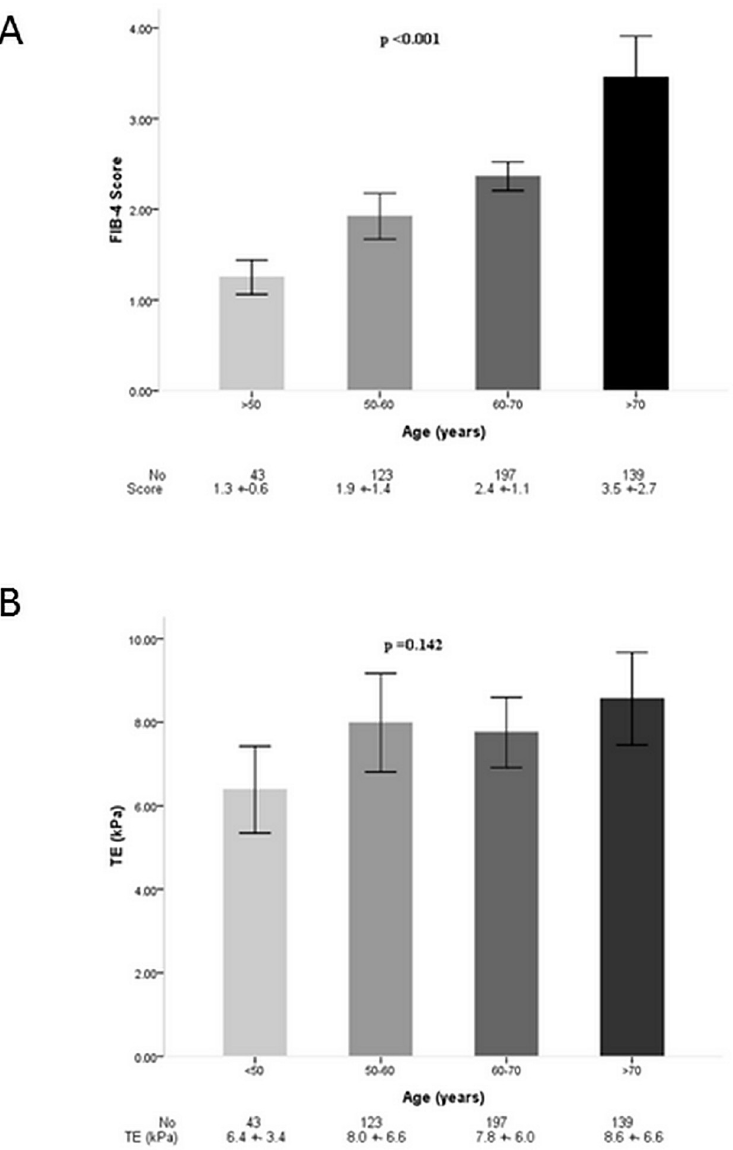
Fig 2. Fibrosis distribution of FIB-4 and TE according to age groups. Bar indicates mean values and lines indicated 95% of confidence interval. (A) FIB-4 distribution by age groups; (B) TE distribution by age groups.